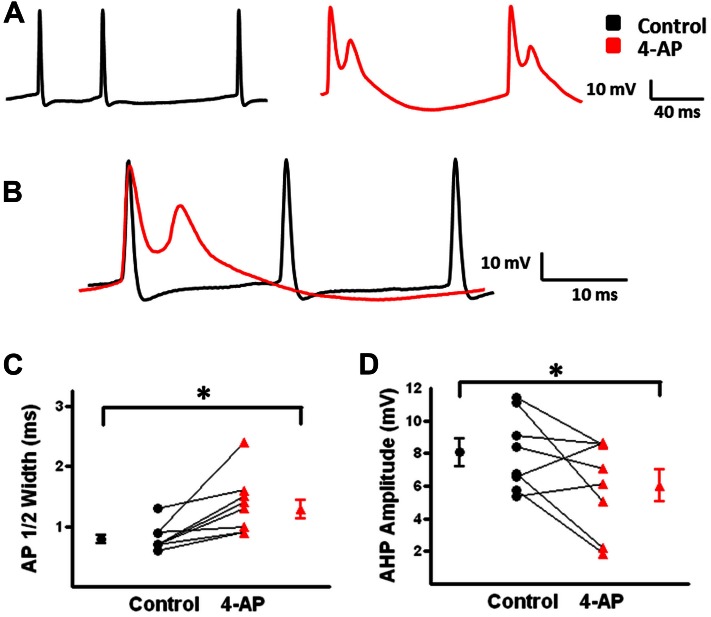
Action potential (AP) properties of b-AC Martinotti cells (b-AC MCs) are modified in the presence of 4-AP. (A) Representative AP firing of a L2/3 b-MC during a 475 pA depolarizing current pulse before (black) and after (red) bath application of 4-AP. (B) Superimposition of APs from A before and after bath application of 4-AP showing spike widening and burst firing in presence of 4-AP. (C) Summary plot demonstrates that bath application of 4-AP significantly increases AP duration in MCs (n = 10). (D) Summary graph illustrating that the AHP after each AP in b-AC MCs was significantly reduced by bath application of 4-AP (n = 10). ∗p < 0.05.